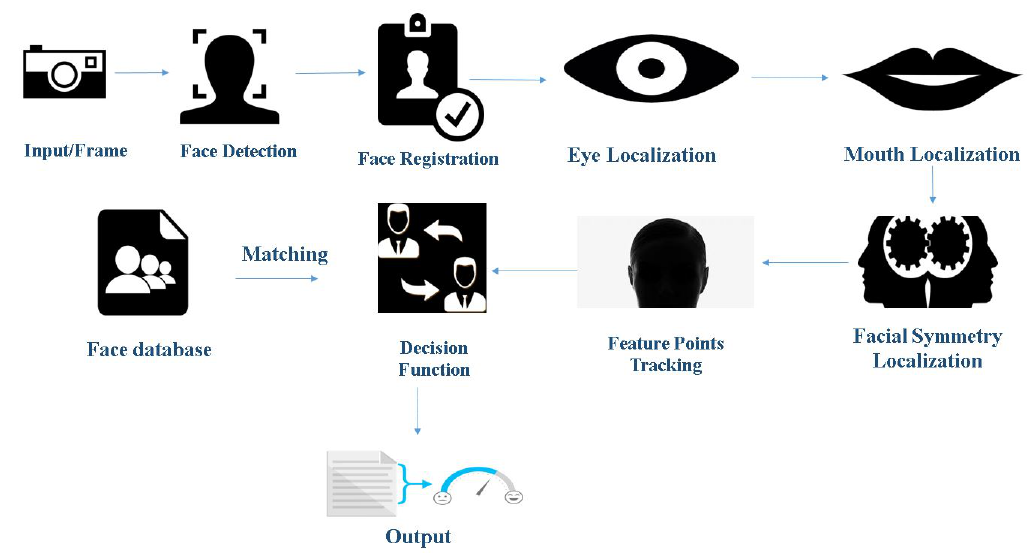
Figure 2. Face detection and emotion recognition using geometric feature-based